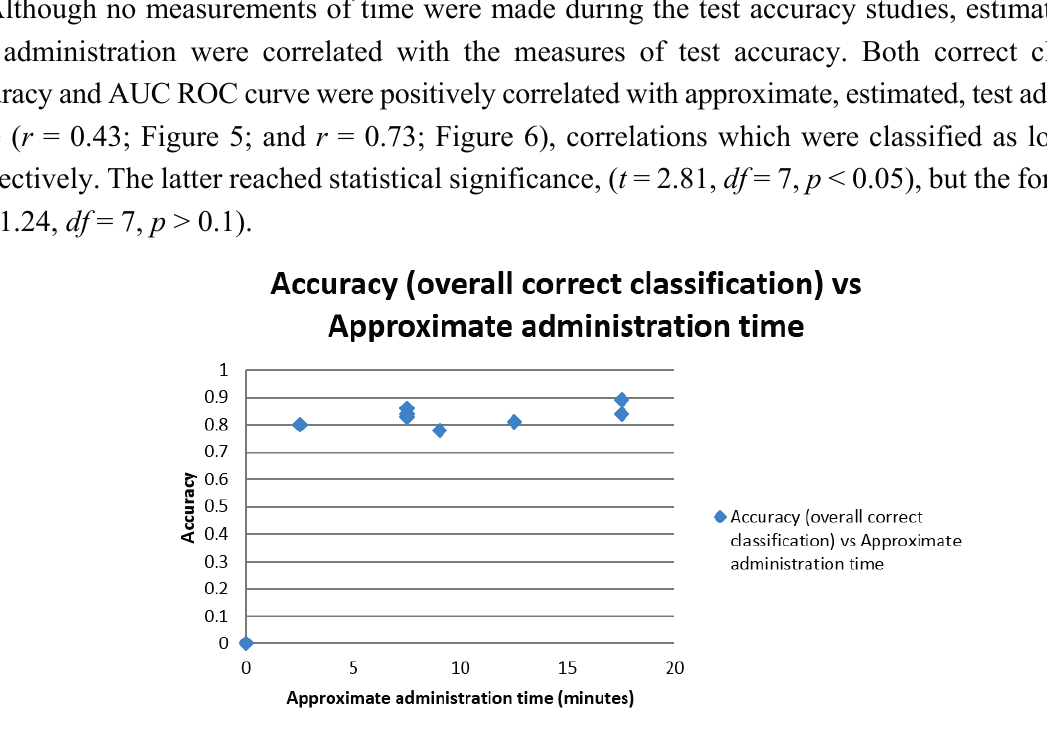
Figure 5. Scatter plot of test correct classification accuracy versus approximate test administration time.